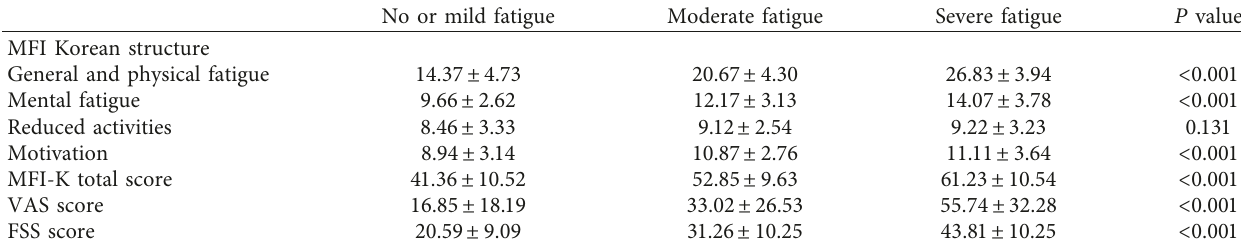
Table 6: Univariate F -test for group differences on subclass of the MFI Korean structure. No or mild